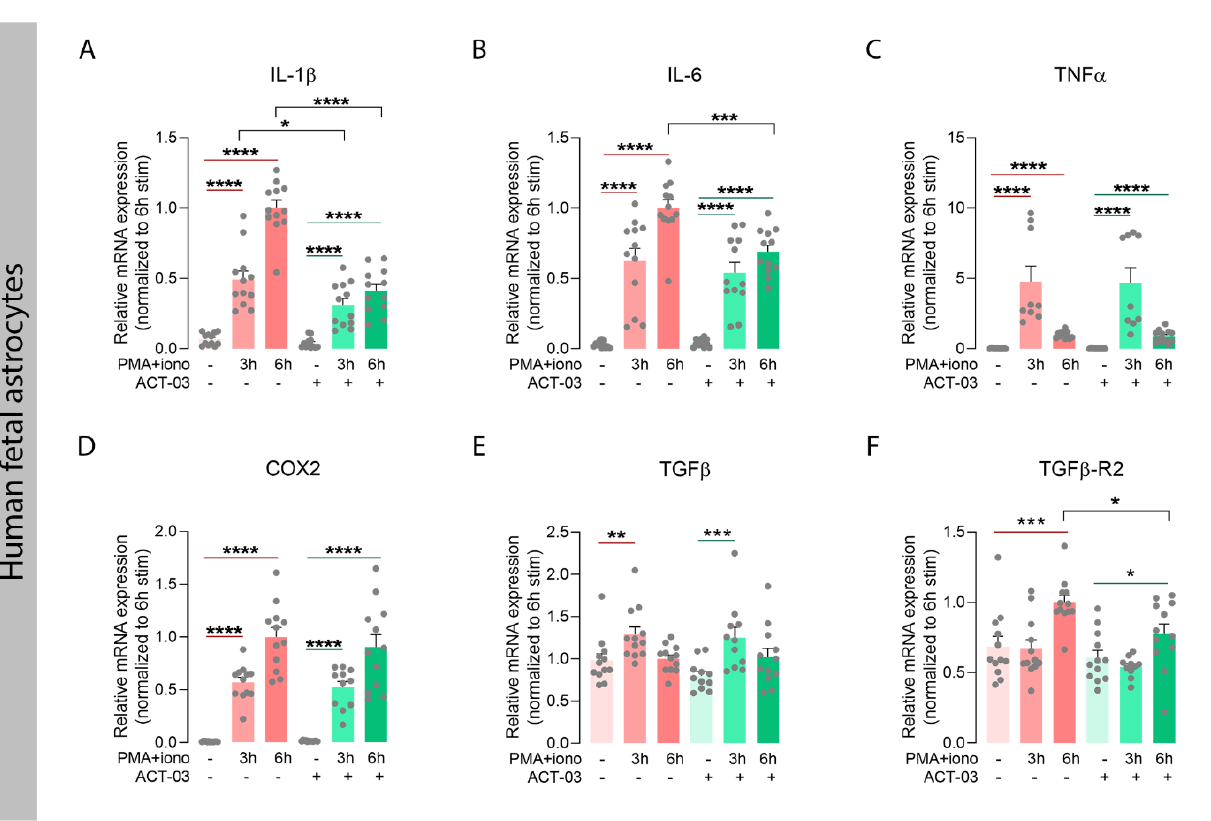
Figure 4. Attenuation of inflammatory factors by ACT-03 in human fetal astrocytes. ( A – F ) Quan- titative PCR of inflammatory mediators shows that stimulation of human fetal astrocytes ( n = 4 donors in experimental triplicates) increases relative mRNA expression of interleukin 1 beta (IL-1 β ), IL-6, tumor necrosis factor alpha (TNF α ), cyclo-oxygenase 2 (COX2), transforming growth factor beta (TGF β ) and TGF β receptor 2 (TGF β -R2) in response to 3 h and/or 6 h stimulation with 50 nM phorbol myristate acetate (PMA) and 1000 nM ionomycin (iono) ( p < 0.01). Simultaneous treatment with 150 µ M ACT-03 resulted in a decrease mRNA expression IL-1 β , IL-6, and TGF β -R2 compared to PMA + iono stimulation solely ( p < 0.05). Bar graphs display mean + SEM, with individual values as dots; *, p < 0.05; **, p < 0.01; ***, p < 0.001; ****, p < 0.0001. Within treatment comparisons indicated with red/green lines. Between treatment comparisons indicated with hooked black